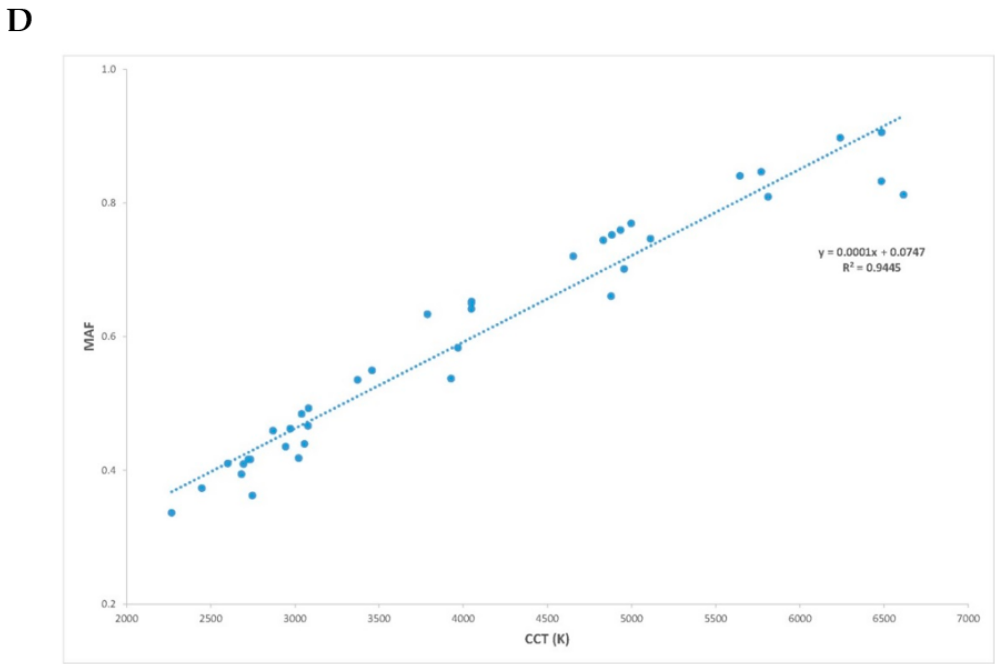
Figure 3. Melanopic illuminance calculated (for 100 lux photopic) using the CIE ( A ), WELL ( B ), and Rea ( C ) metrics with the LEDs divided by CRI90, CRI95, and CRI99. The MAF parameter (calculated by Equation (4) is a function of the CCT ( D ).